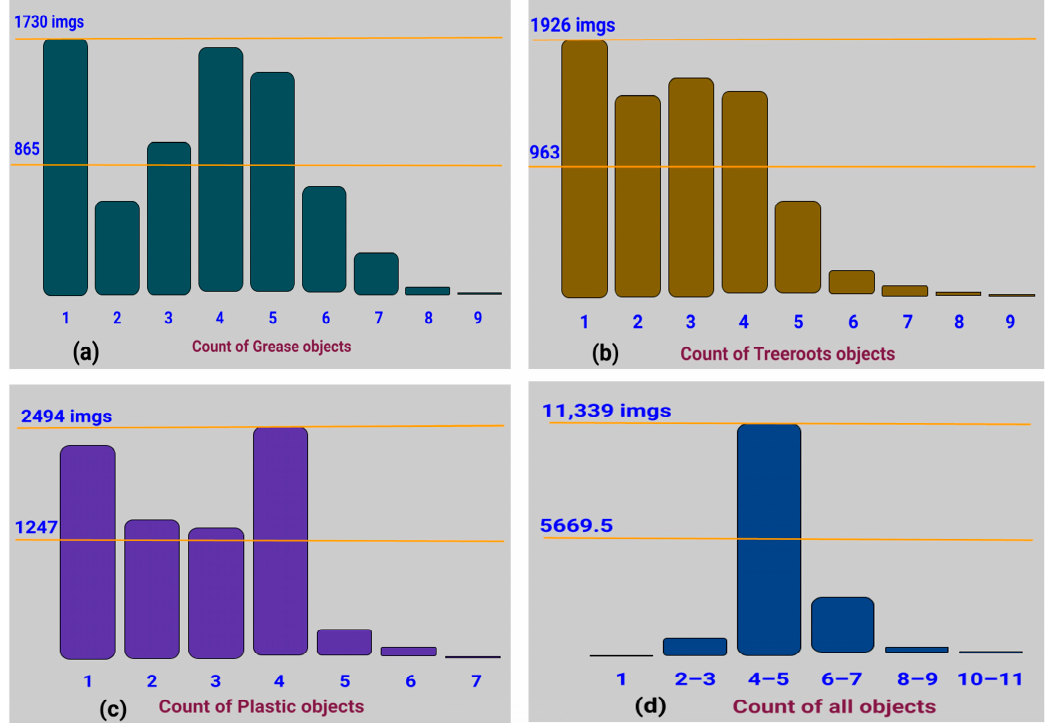
Figure 16. Object count histogram for: ( a ) grease, ( b ) tree roots, ( c ) plastic, and ( d ) all classes.